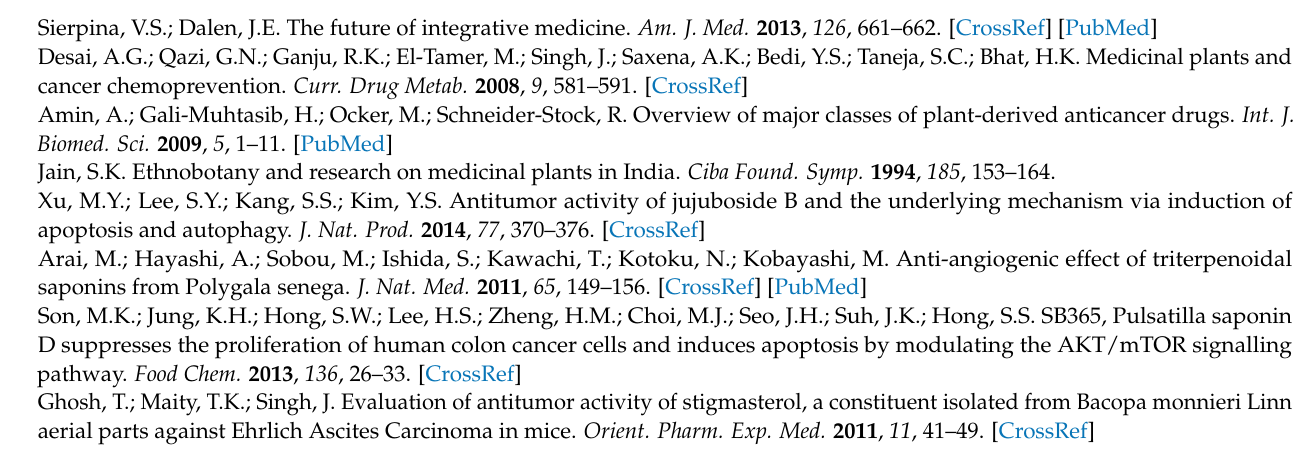
Figure S1: Bacopaside I and II combined induced annexin V positivity in HT-29, 2H-11 and